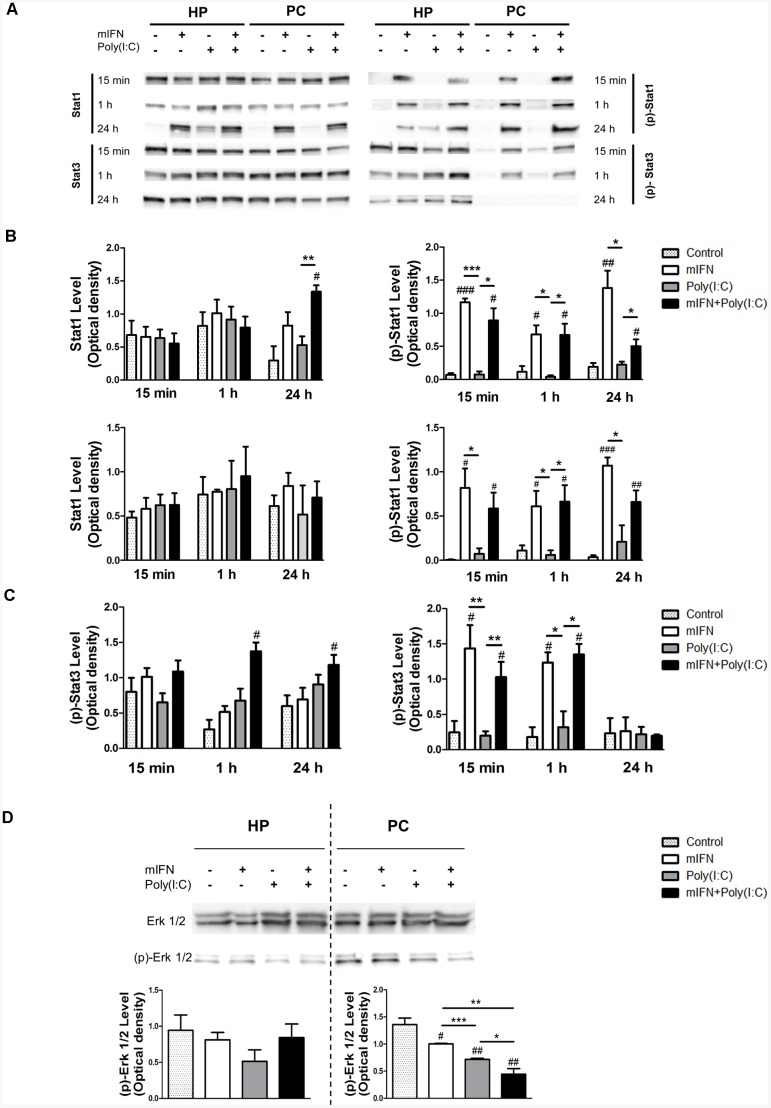
Protein level analysis of the main effectors of IFN and poly(I:C) pathways in cultured neurons.Hippocampal (HP) and prefrontal cortical PC) neurons stimulated at 8–9 div during 15 min, 1 h and 24 h with mIFN (1,000 IU/mL), poly(I:C) (100 µg/mL) and both treatments were lysed and protein collected for analysis. Representative western blots (A) and quantification (B,C) showing the activation of Stat1 and Stat3 at all studied time points, and Erk 1/2 after 24 h (D). Significance related to the control condition is showed with #, while asterisks indicate significant variations between treatments (* or # p<0.05; ** or ## p<0.01; *** or ### p<0.001) using the Student's t-test.